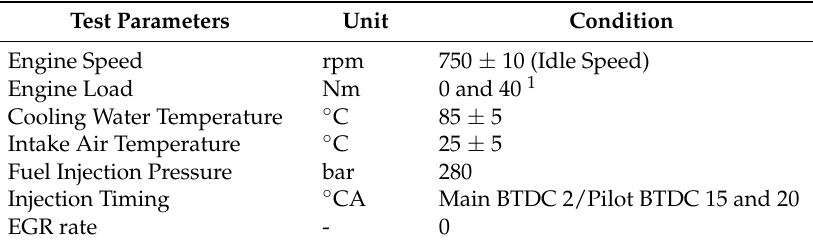
Table 3. Test Conditions.